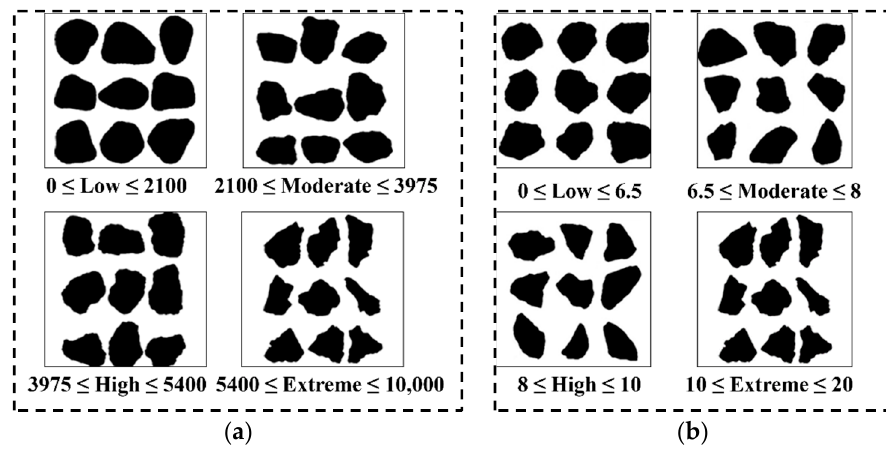
Figure 6. Schematic diagram of angularity and form2D: ( a ) angularity ( b ) and form2D.